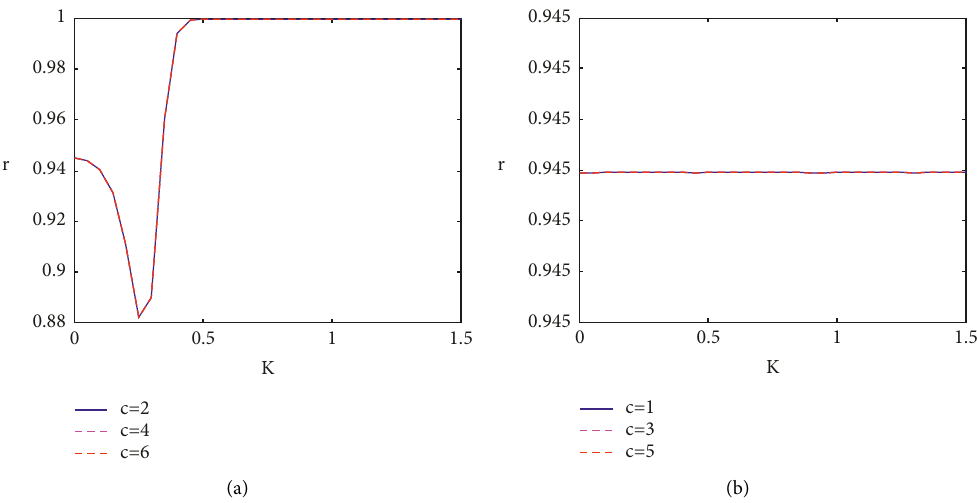
Figure 6: The evolutions of order parameters for a ring network with different weight coefficients: (a) the interconnections of network are positive; (b) the interconnections of network are negative.